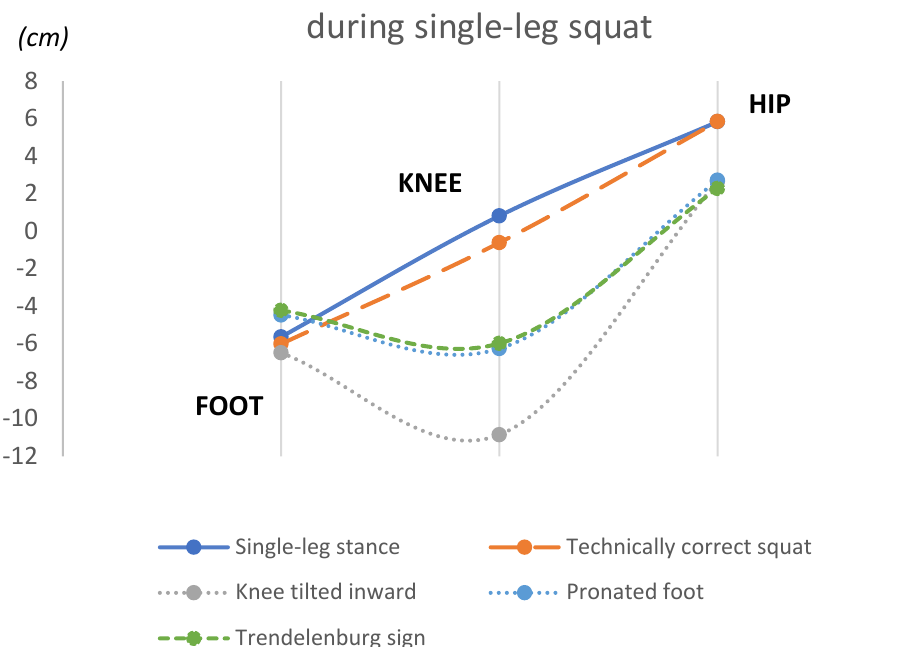
Figure 2. Representative changes of the knee medio-lateral coordinates under the single-leg stance and during technically good and poor squats as demonstrated by a healthy athlete. The y axis shows the medio-lateral positions of the respective joint midpoints during stance and squats. In the case of standing or a technically correct squat, the three joints form a straight line, indicating that the load is centered on the midline of the knee. In the case of the Trendelenburg hip or the pronated foot tests, the knee moves to the medial side from the midline; however, one can produce a higher level of valgus by keeping the knee in a deliberate valgus position throughout the squat.